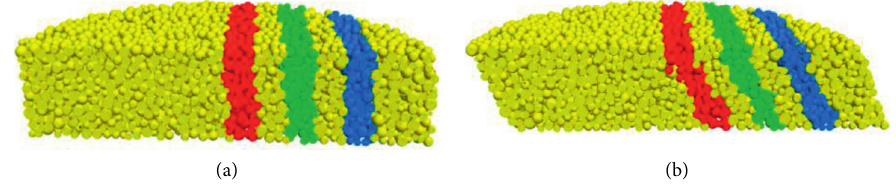
Figure 13: Movement of particles: (a) after consolidation; (b) at 40% shear strain